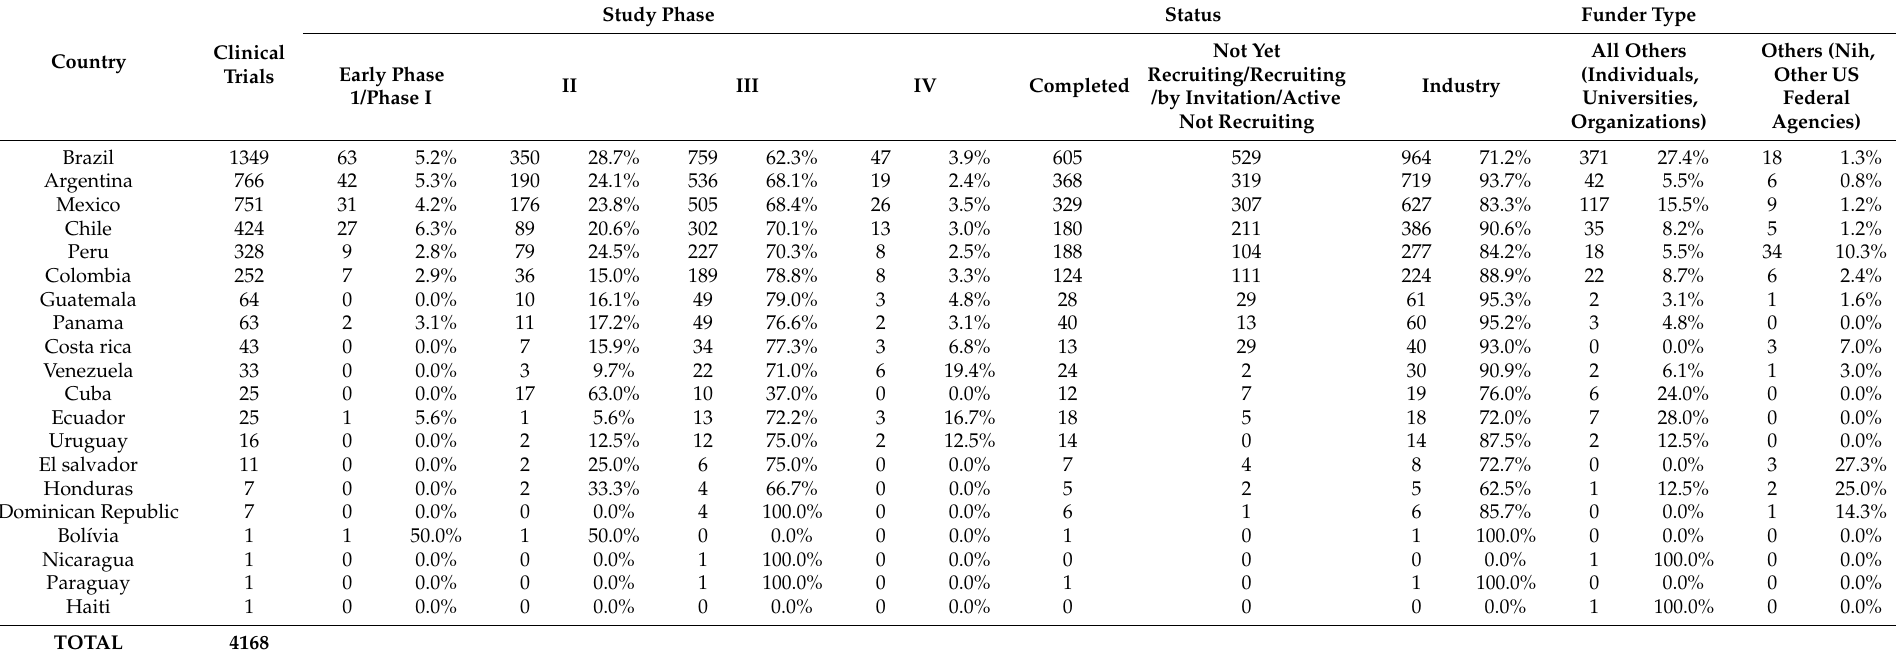
Table 1. Cancer clinical trials conducted in Latin America and the